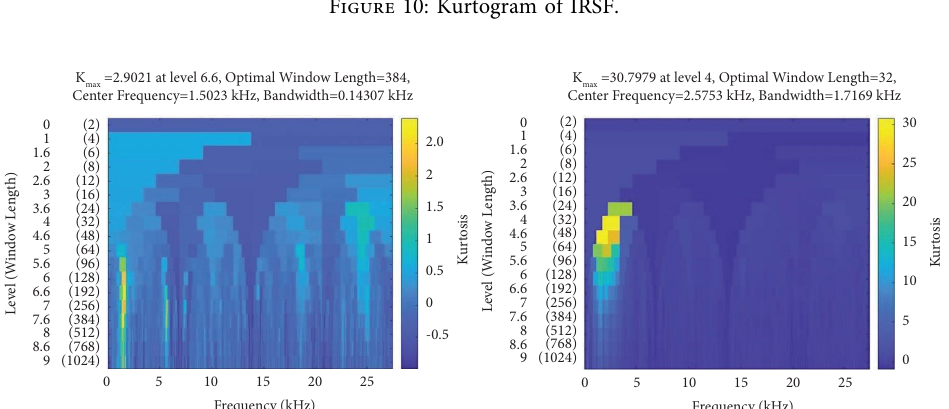
Figure 10: Kurtogram of